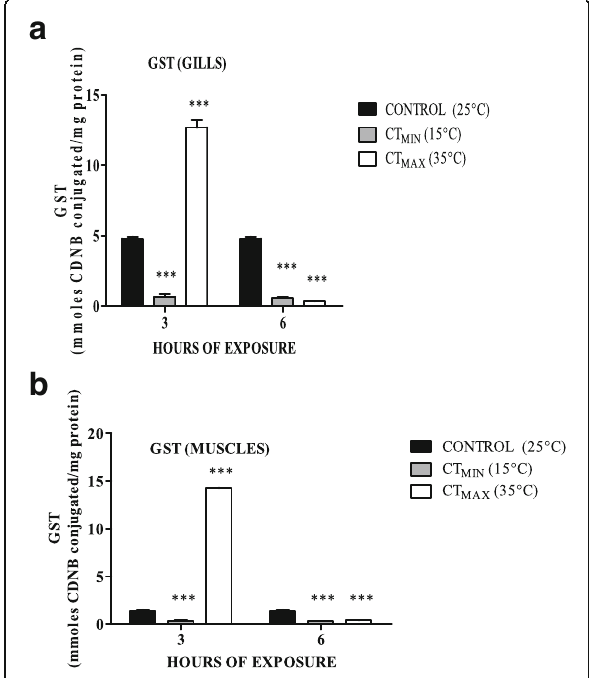
Fig. 2 Effect of temperature on the activity of catalase in the gills ( a ) and muscles ( b ) of Koi carps. Significance was calculated by two- way ANOVA followed by Bonferroni post-test where p < 0.001 (***); p < 0.01 (**); p < 0.05 (*). The vertical lines indicate mean ± SE. Bars represent different periods of exposure